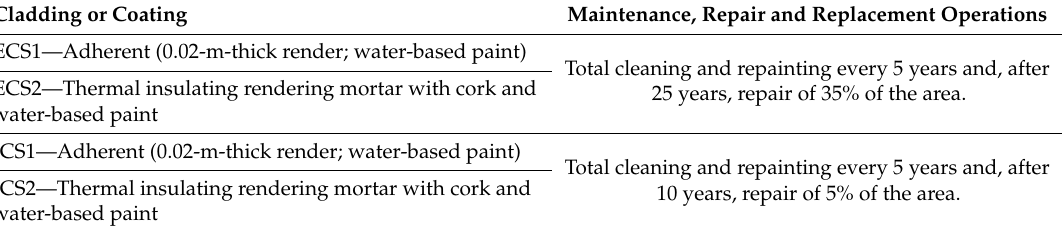
Table 2. Maintenance, repair and replacement operations of each external cladding and internal coating of external wall evaluated.